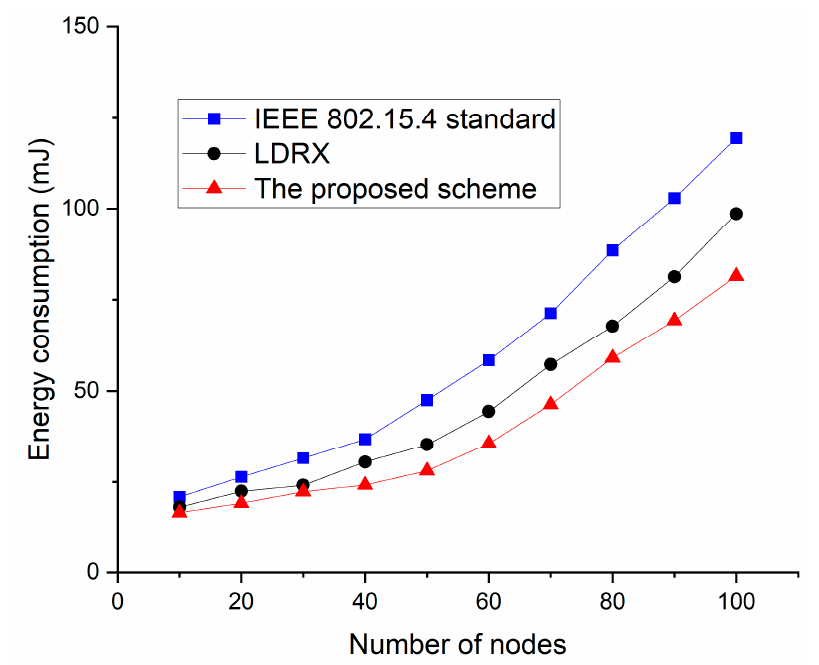
Figure 12. Energy consumption as a function of the number of devices.